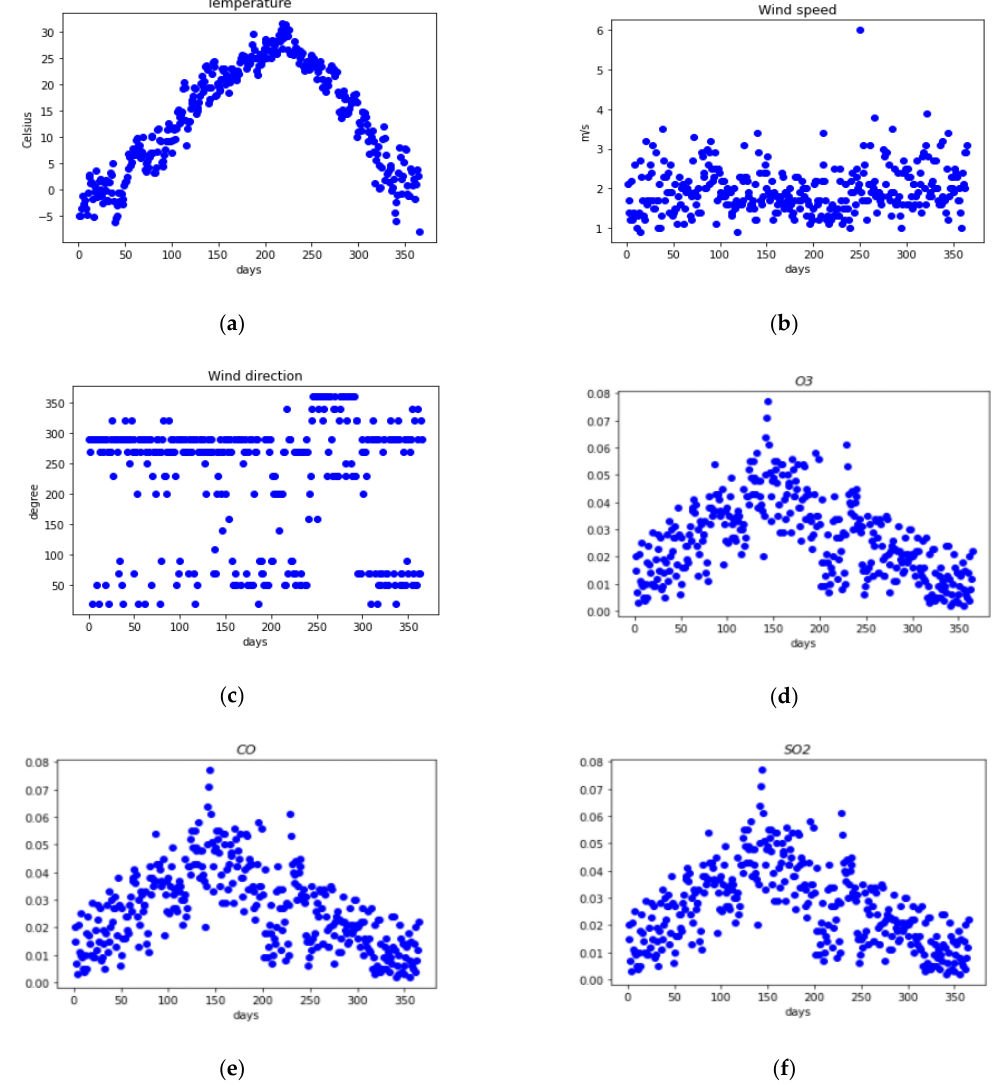
Figure 4. Raw weather data with ( a ) temperature, ( b ) wind speed, ( c ) wind direction, ( d ) ozone, ( e ) carbon monoxide, and ( f ) sulfur dioxide in Seoul (2019).